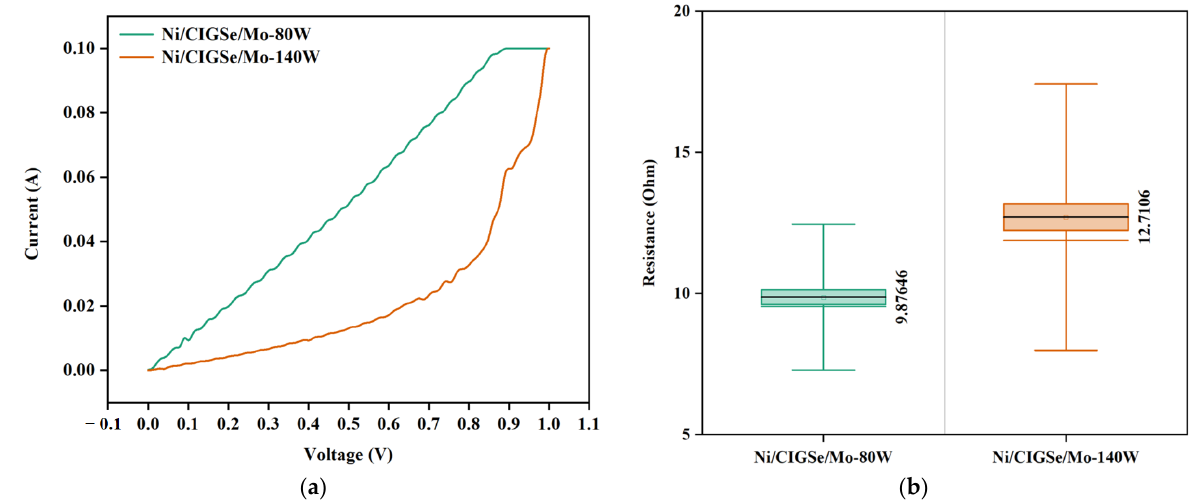
Figure 9. ( a ) Dark I ‐ V characteristic of the device with Ni/CIGSe/Mo structure; ( b ) Stack Resistance.